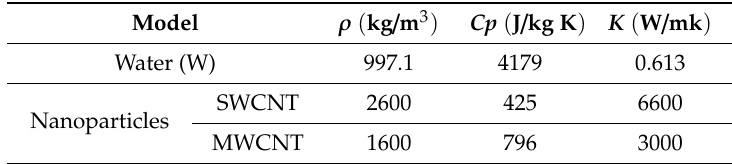
Table 1. The thermophysical properties of single- and multiple-wall carbon nanotubes (SWCNTs / MWCNTs) and the base fluid